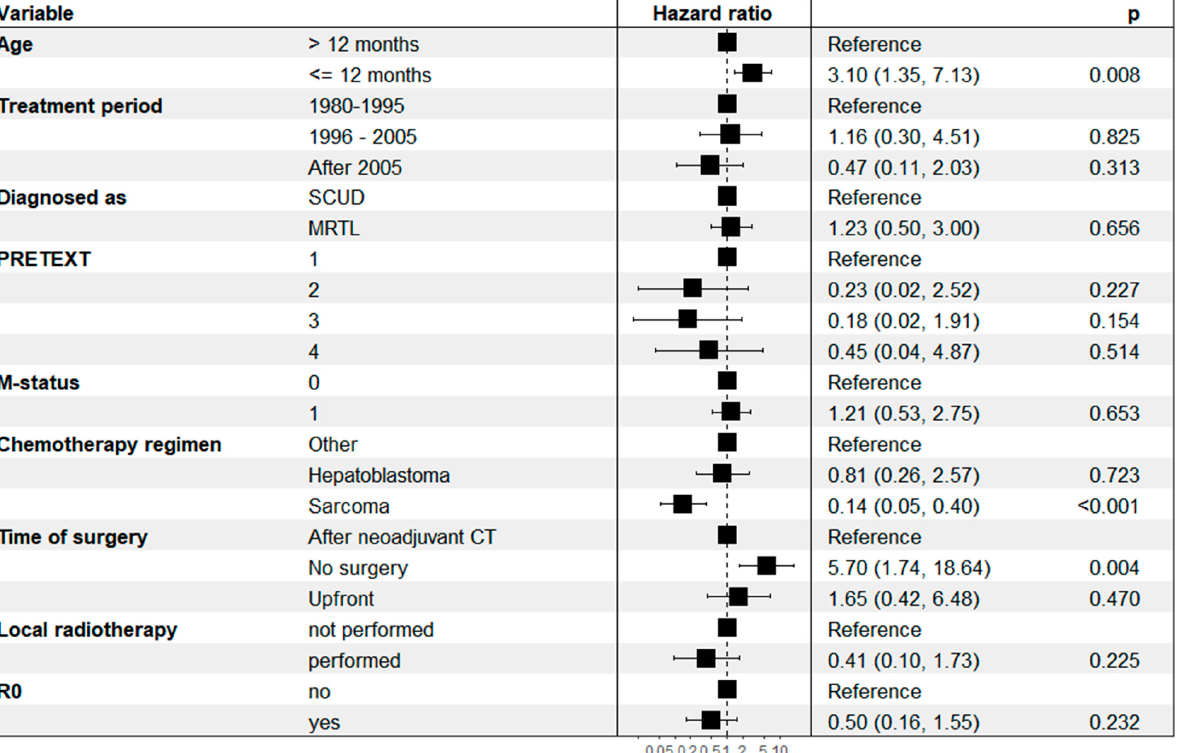
Figure 7. Multivariable Cox regression analysis with hazard ratios. Table 5. Outcome.